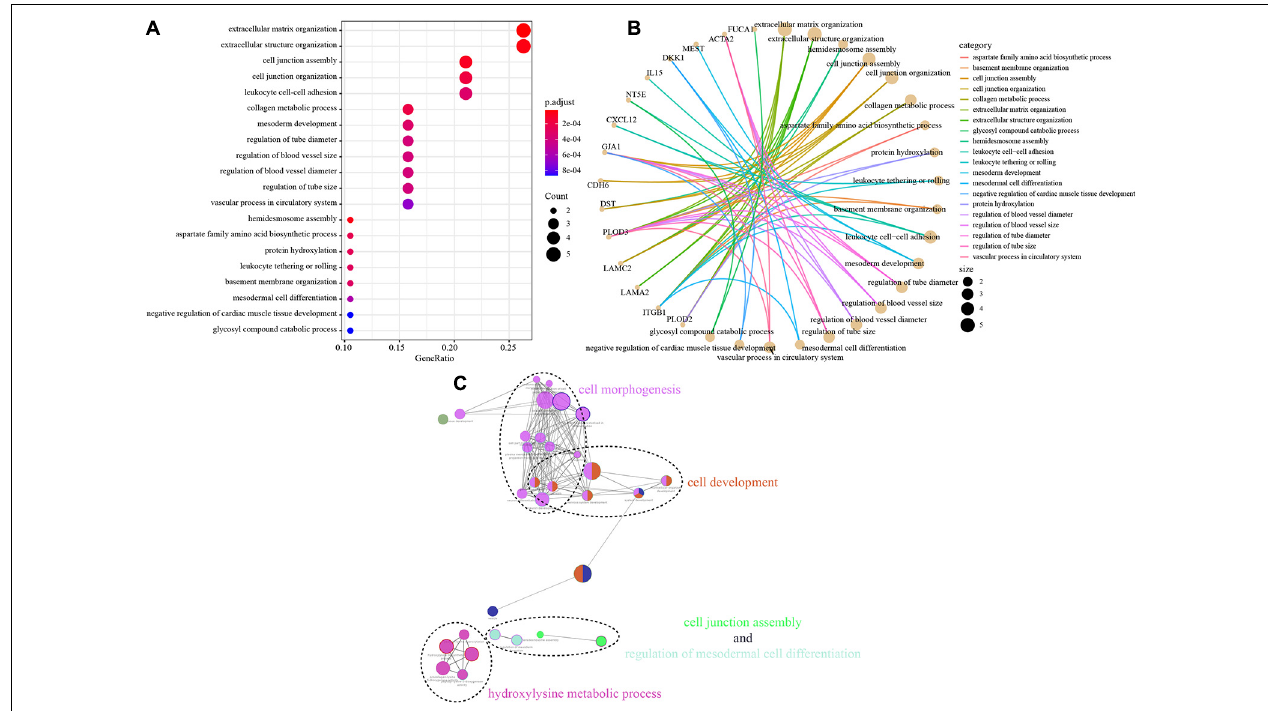
FIGURE 5 | Functional analysis of the EMT-related gene signature. (A,B) The most significantly enriched KEGG pathways. The node size represents the number of genes in the pathways, and the color represents the pathway enrichment significance. (C) Functionally grouped network with enriched GO terms as nodes linked based on kappa score threshold of 0.4. Node size represents the term enrichment